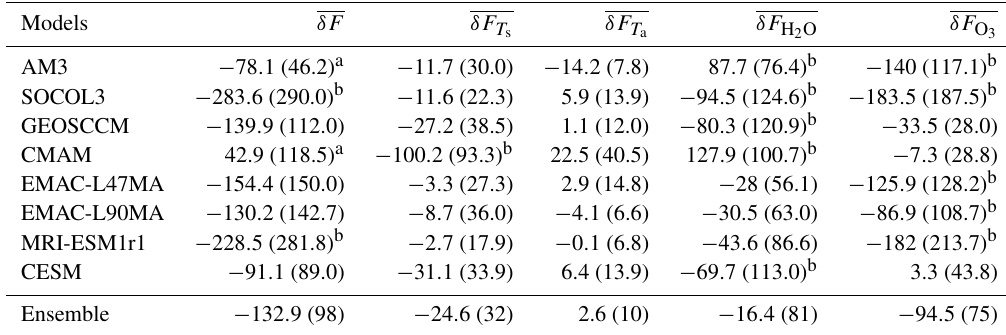
Table 2. The global mean of the flux bias (mWm − 2 ) and the dominant components due to tropospheric O 3 , H 2 O, T a , and T s . The numbers in parentheses are the standard deviation of the zonal distribution. For the ensemble, the standard deviation is computed from the variation between the models.